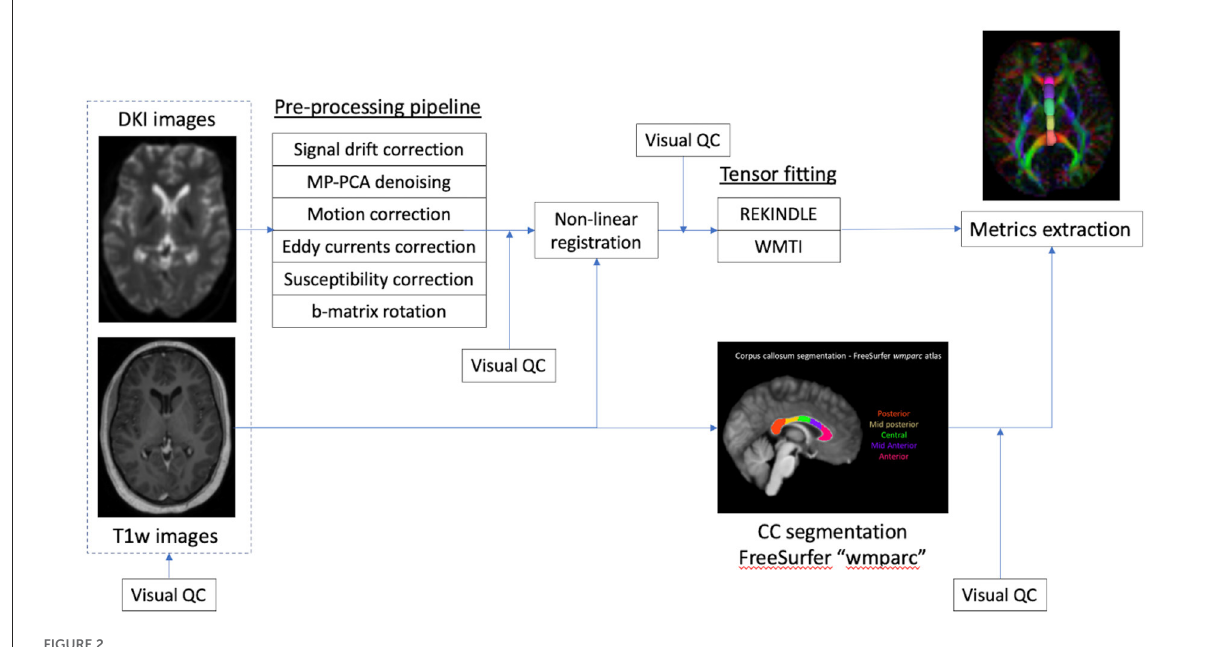
FIGURE2 DTI post-processing